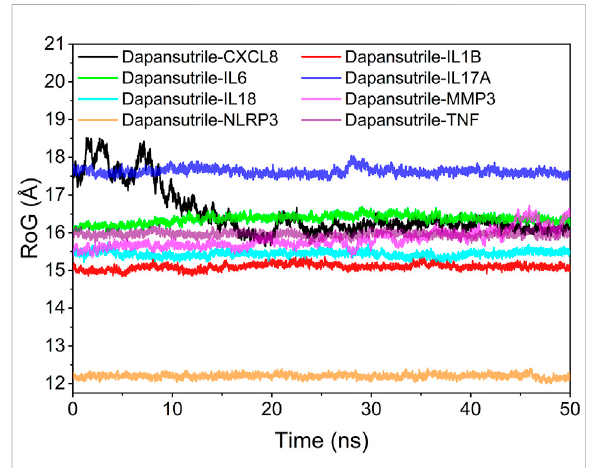
FIGURE 8 Analysis of protein folding state and overall conformation.